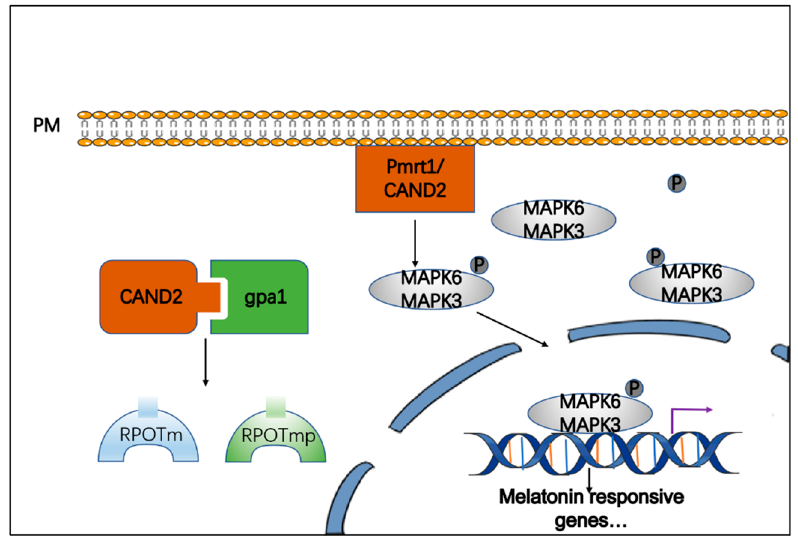
Figure 2. Melatonin signaling pathway from melatonin perception to action. Melatonin promotes the production of its receptor protein, enabling upstream MKK to activate MAPK3 and MAPK6, thereby activating melatonin signal.